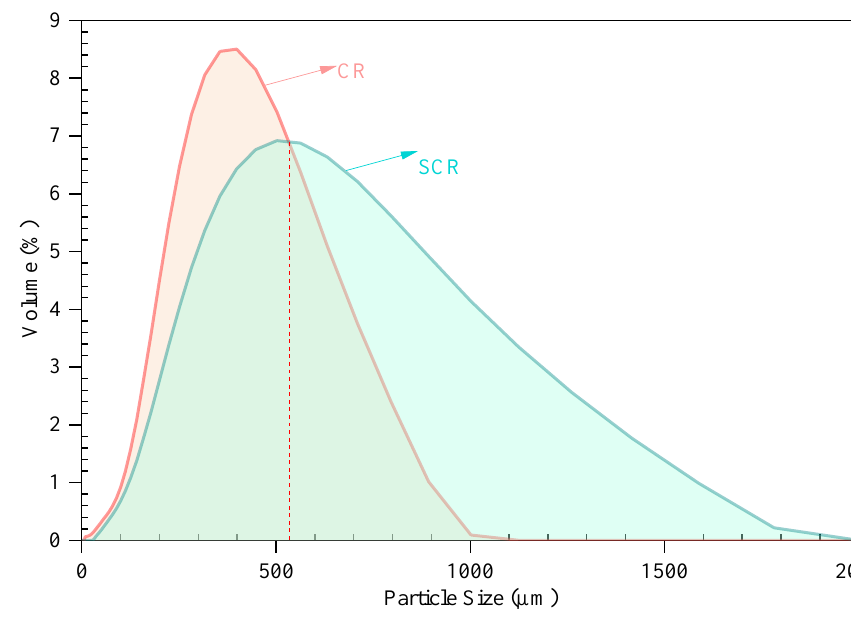
Figure 10. Softening Point Difference of CRMB.